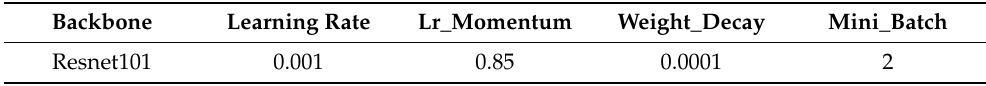
Table 1. Network Table 1. Network hyperparameters.